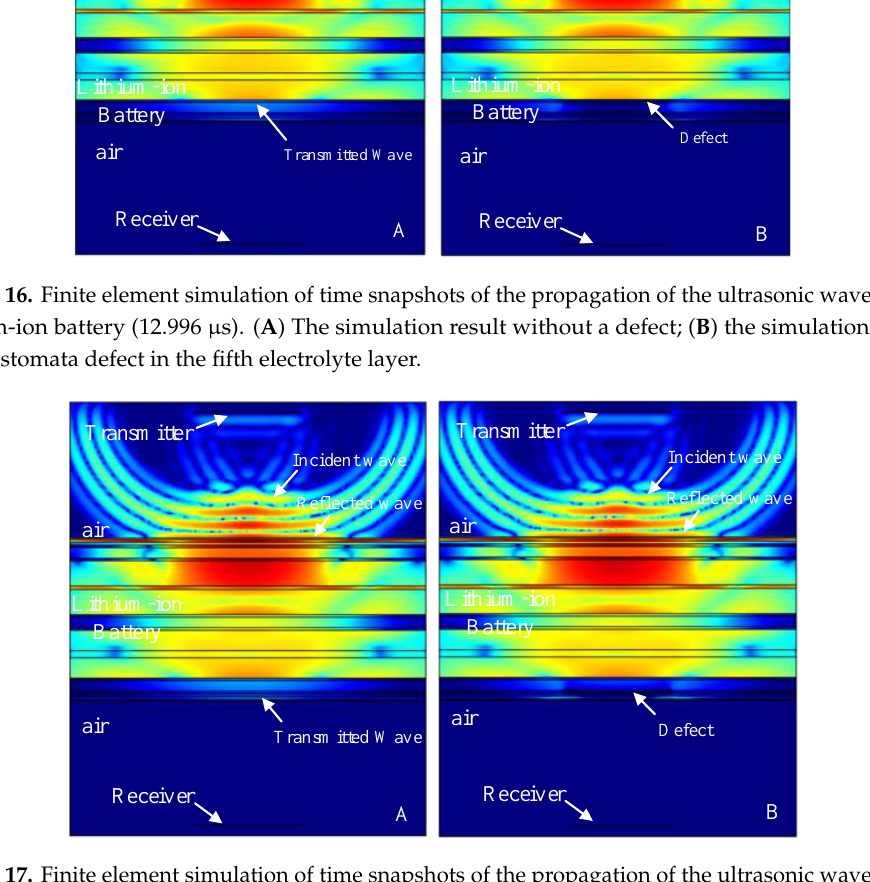
Figure 17. Finite element simulation of time snapshots of the propagation of the ultrasonic wave in the lithium-ion battery (13.122 µ s). ( A ) The simulation result without a defect; ( B ) the simulation result with a stomata defect in the sixth electrolyte layer.